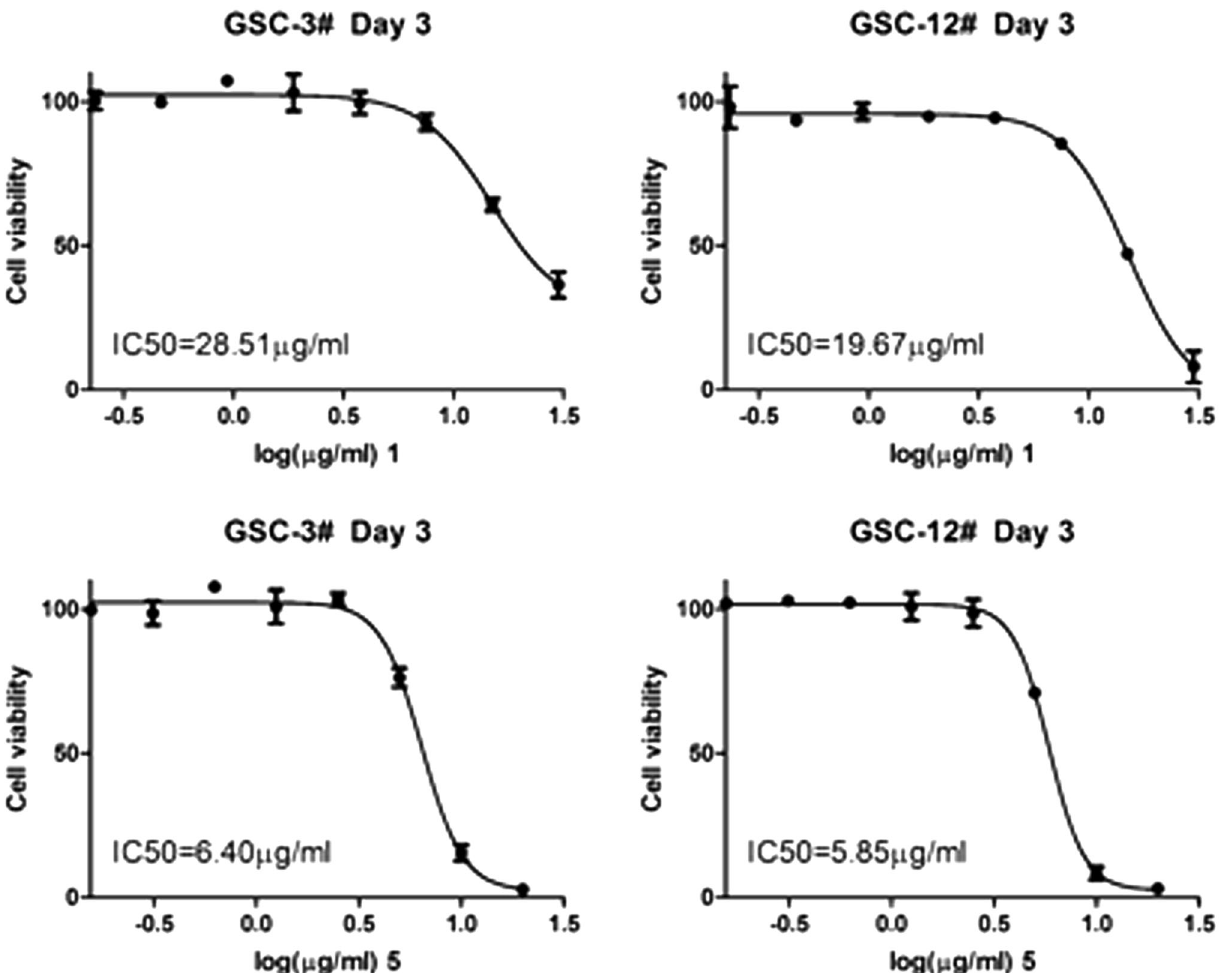
Fig. 5 The IC 50 value for compounds 1 and 5 against human glioma stem cell